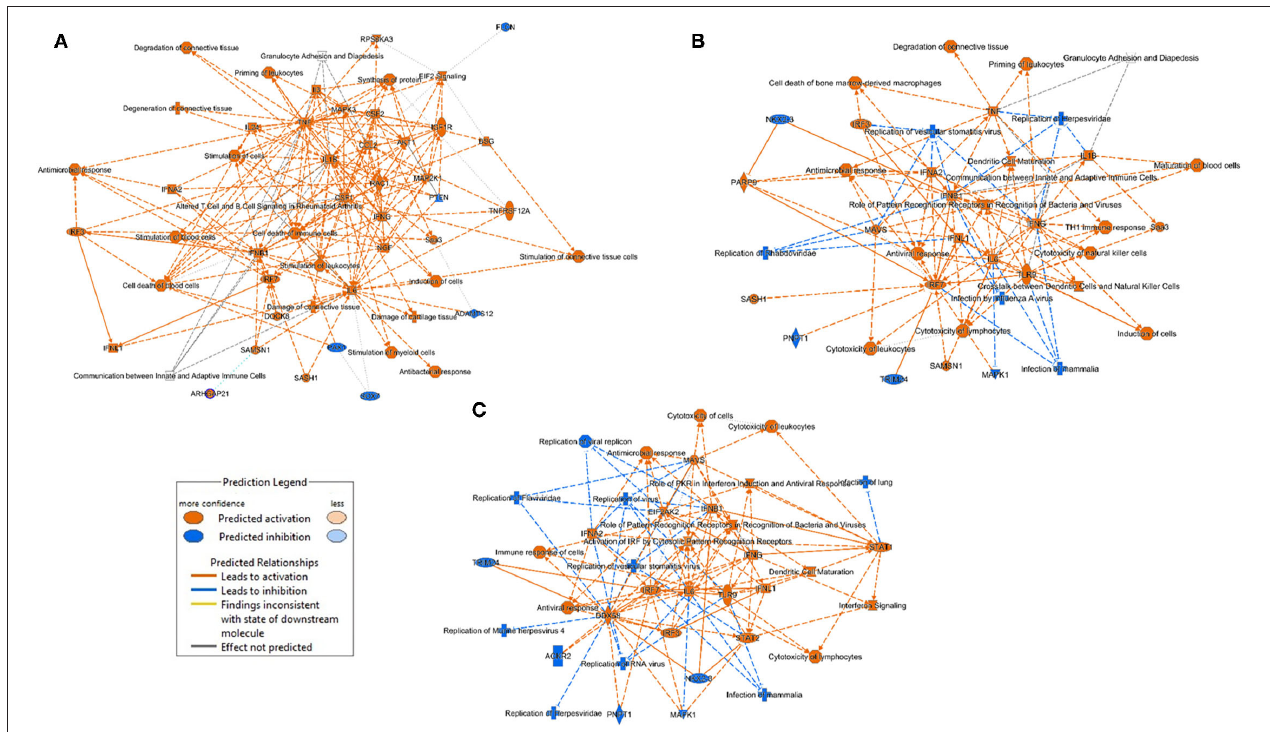
FIGURE 6 | Graphical summary of the major biological processes predicted by the Ingenuity analysis. (A) LDR mice (B) LDR-SC2 mice (C) SC2